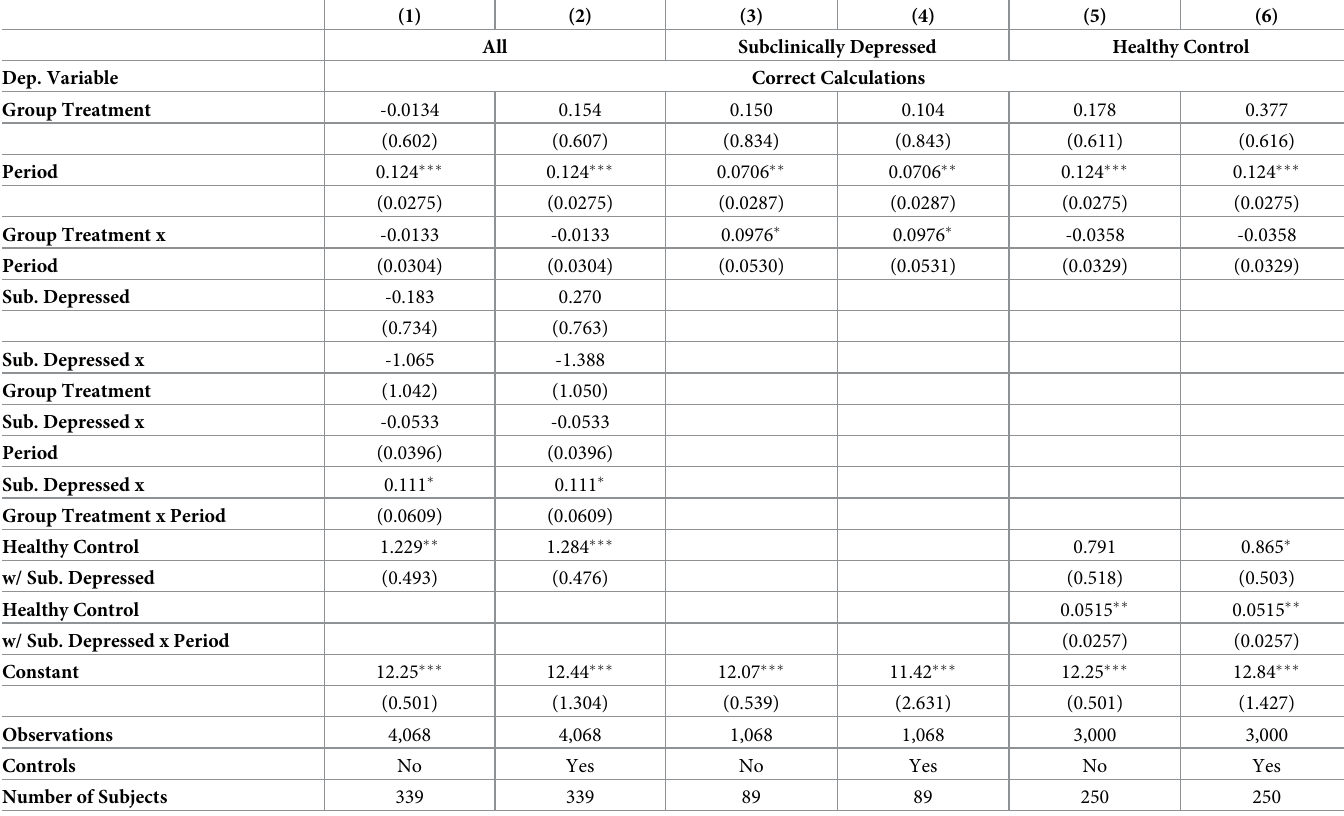
Table 7. Panel regression on correct calculations in the subclinical sample.